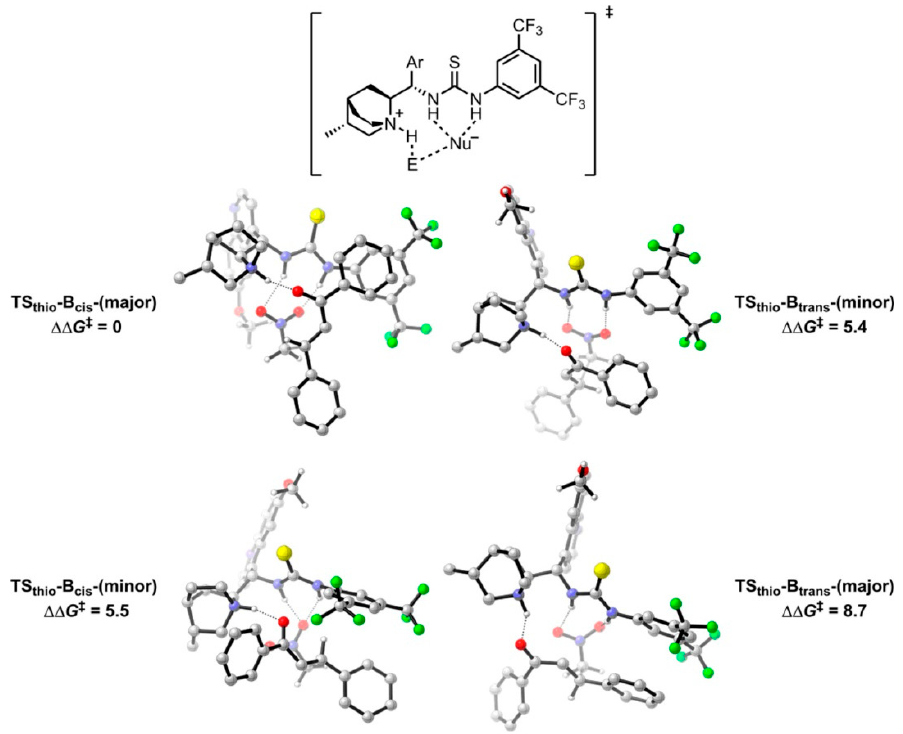
Figure 19. C − C bond-forming TSs in the cinchona thiourea-catalyzed asymmetric Michael addi- tion of nitroalkanes to enones shown in Figure 18, according to mode B. M06-2X/def2-TZVPP- IEFPCM(toluene)//M06-2X/6-31G(d)-IEFPCM(toluene). The noncritical hydrogen atoms were omitted for clarity. All energies are in kcal mol − 1 . Reprinted and adapted from Grayson, M.N. J.